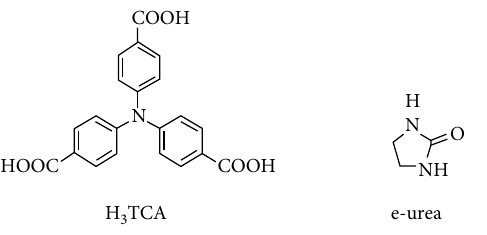
Scheme 1: The chemical drawing for the ligands used in this work. Table 1: Crystal data for compound